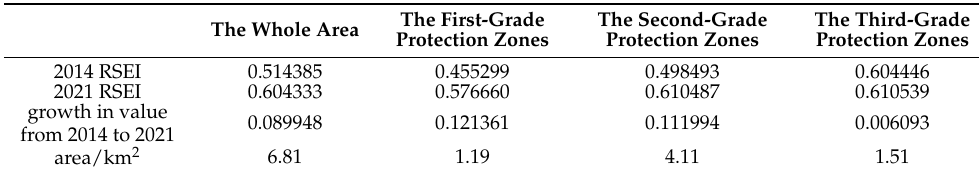
Table 4. Remote sensing ecological index of different governance areas and the overall area from 2014 to